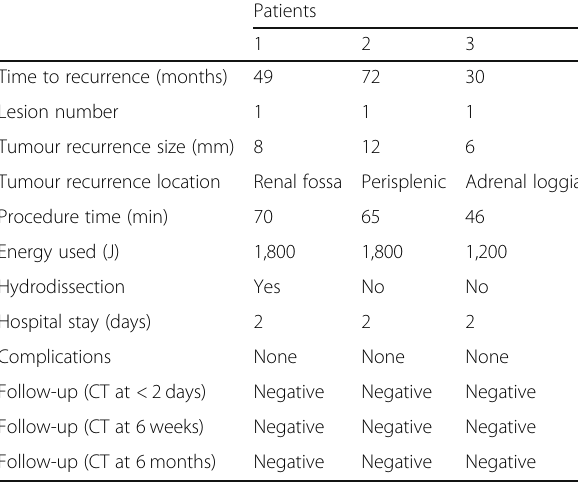
Table 2 Details of recurrent tumour, procedure, and follow-up